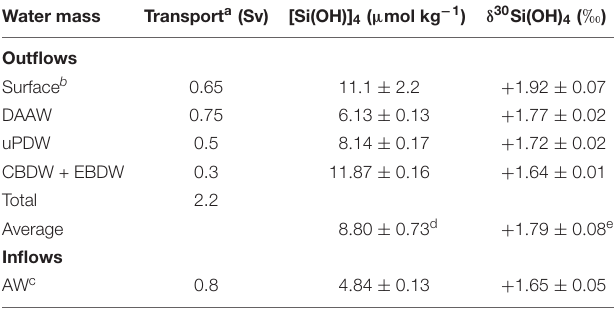
TABLE 5 | Estimated isotopic composition of silicic acid inflows and outflows through the Fram Strait. Water